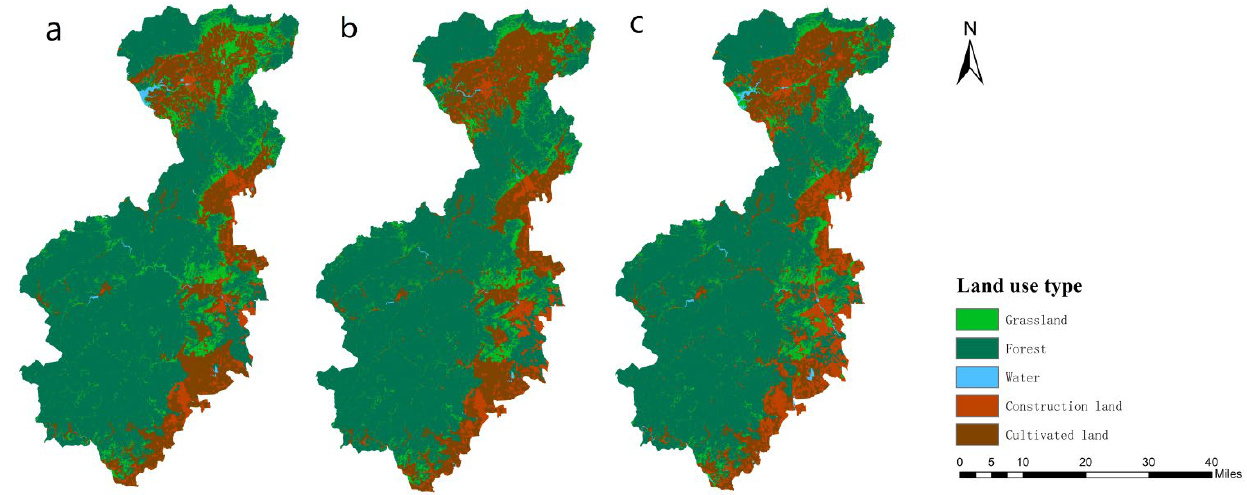
Figure 3. Spatial distribution of land-use types in the ECA in western Beijing in: ( a ) 2000; ( b ) 2010; ( c ) 2020.